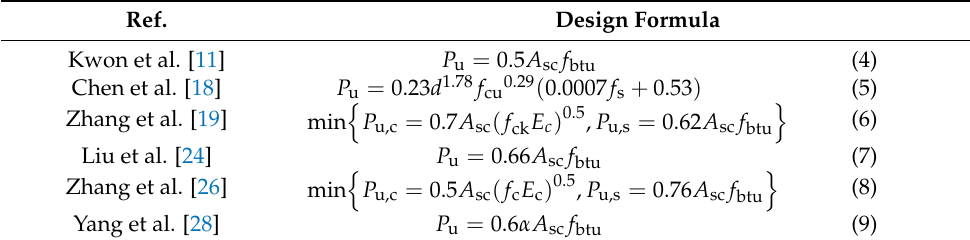
Table 3. Design formulae for shear strength per bolt